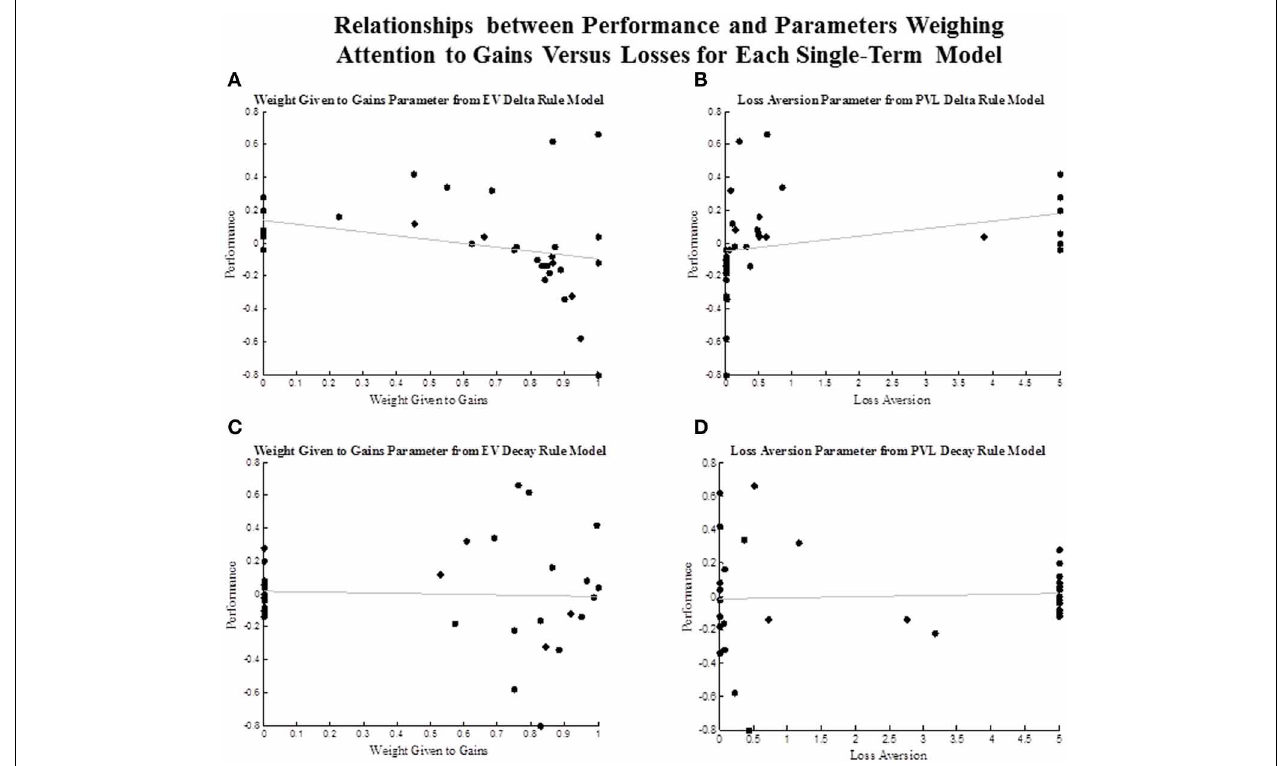
FIGURE 3 | Scatterplot of the association between performance and parameter estimates that weigh the attention given to gains vs. losses. (A) associationbetweenperformanceandtheattentiontogains (w) parameter from the EV Decay Rule model. (B) association between performance and the